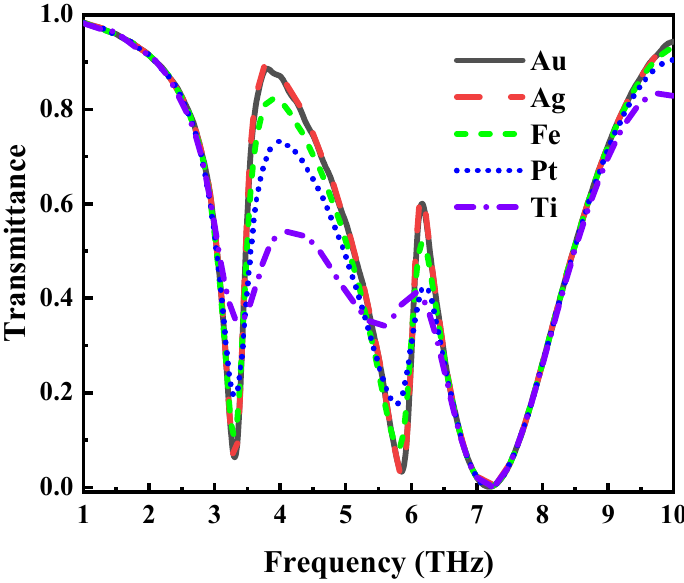
Figure 9. Changes in the transmission spectrum of metal replacement in this structure.